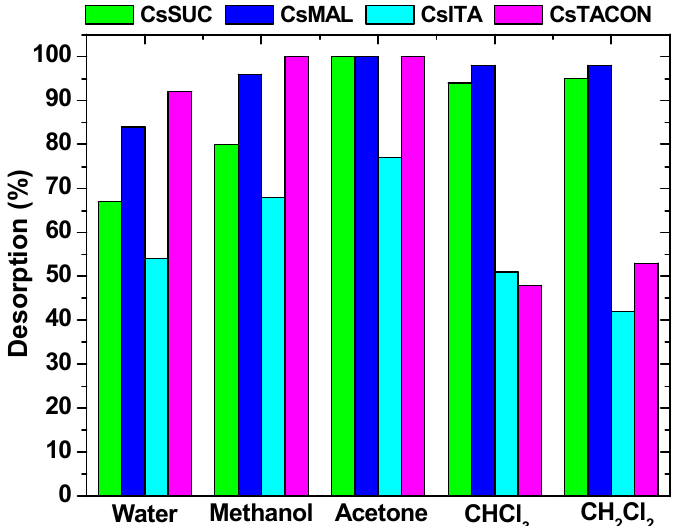
Figure 12. Desorption of various drug compounds by DCF-loaded chitosan adsorbents.